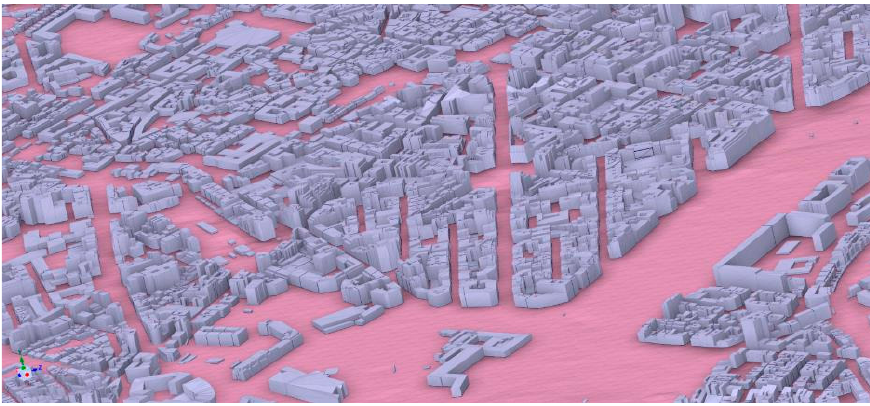
Figure 4. D Model of the city of Leon (Spain). Approximated scale: 1:10,000.